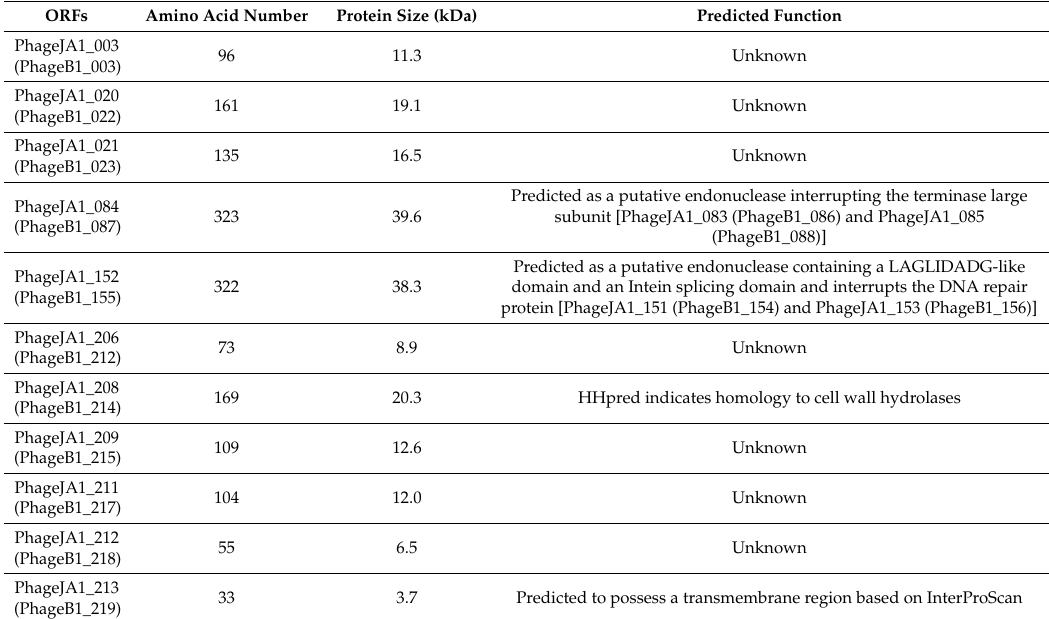
Table 6. List of missing ORFs and their predicted function absent in phage K but present in phages B1 and